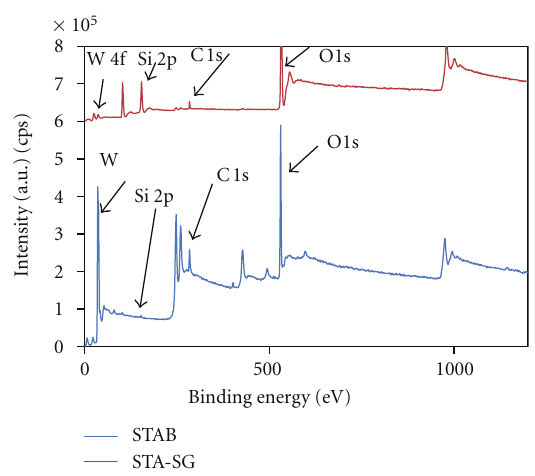
Figure 4: Wide scan for STAB and